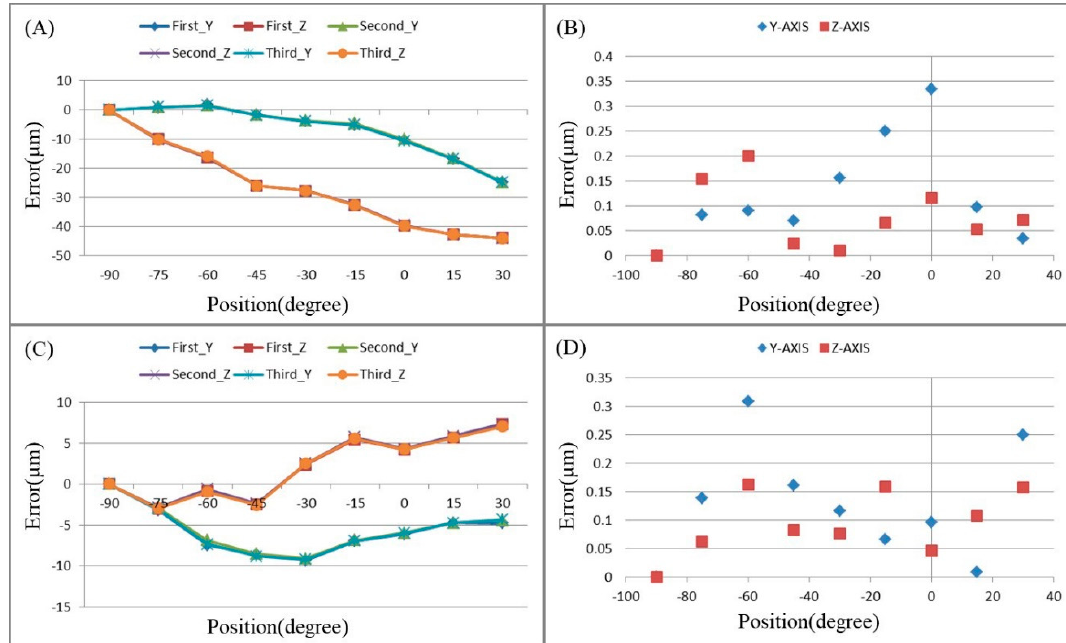
Figure 9. A-axis eccentricity measurement results: ( A ) BK1 path static measurement repeatability before compensation, ( B ) BK1 path static measurement standard deviation before compensation, ( C ) BK1 path static measurement repeatability after compensation, and ( D ) BK1 path static measurement standard deviation after compensation.